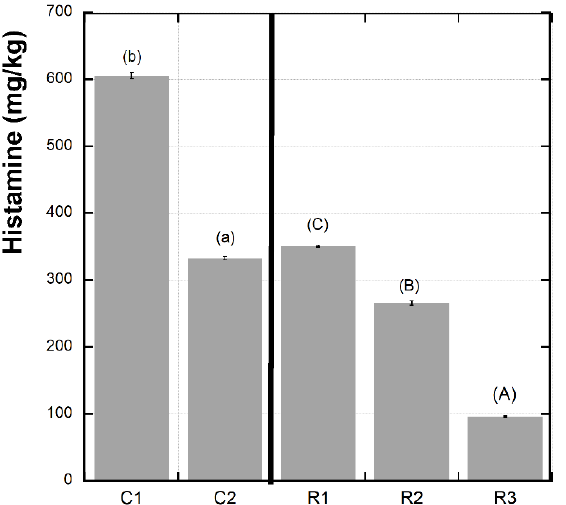
Figure 1. Histamine content in different anchovy sauce samples. Different letters between means indicate statistically significant differences at p < 0.05. Lower-case letters are used for comparing C1–C2 (commercial samples); upper-case letters are used for R1–R2–R3 samples at 12-, 24-, and 48-month ripening).